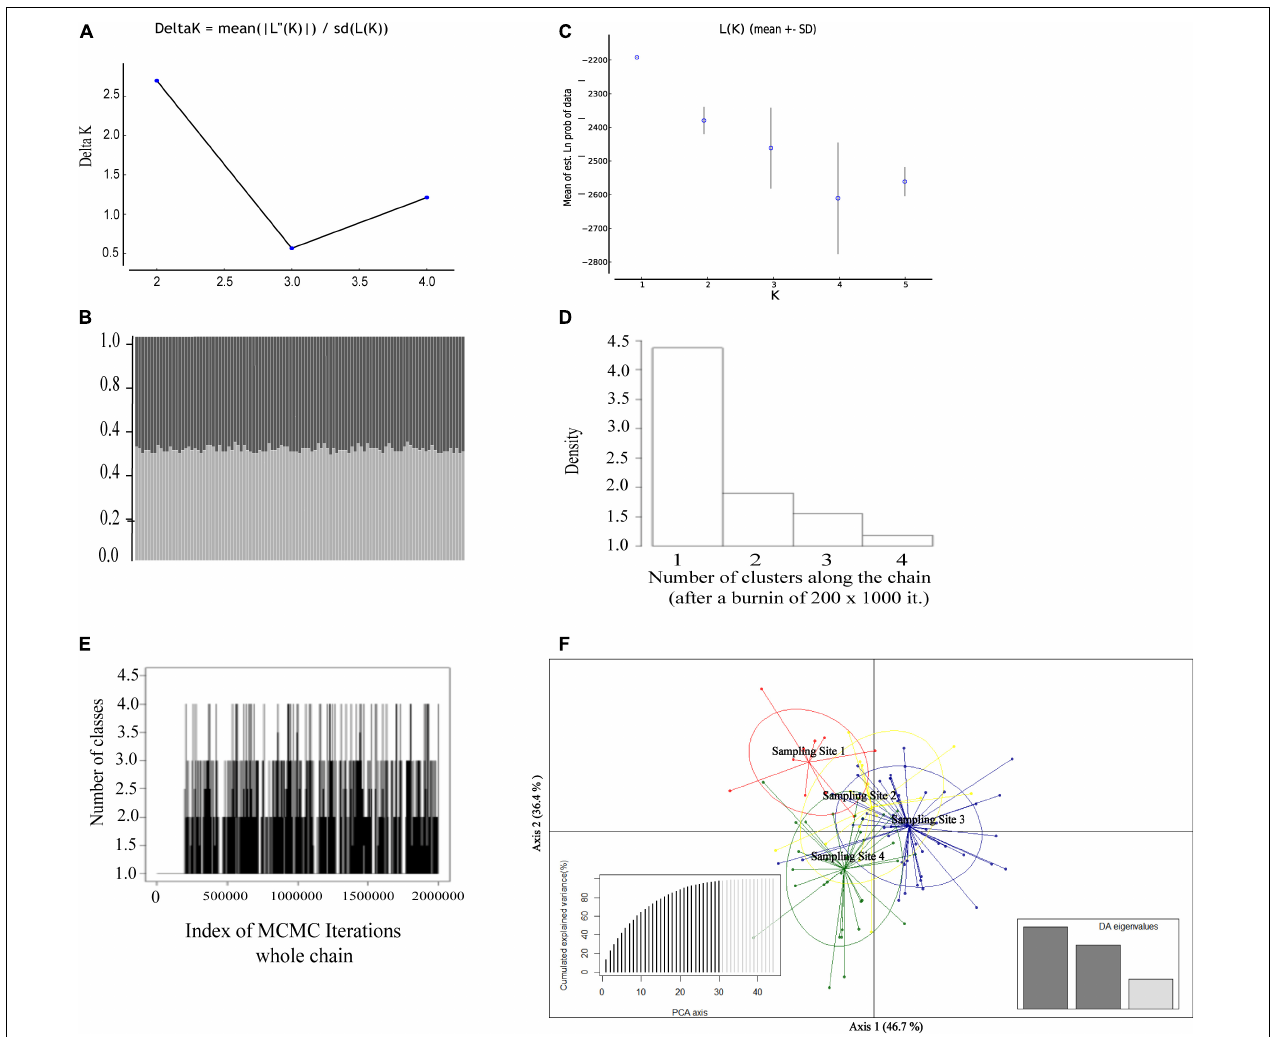
FIGURE 2 | Genetic structure of 107 Myrmecophaga tridactyla specimens assessed by different approaches based on 10 microsatellite loci. (A) Population structure results ( K = 2) based on the (cid:49) K statistic (Evanno et al., 2005). (B) Graphical representation of K = 2 from structure results based on (cid:49) K statistic (Evanno et al., 2005). Each vertical bar represents an individual and each color (light gray and dark gray) represents the posterior probability of the individuals belonging to that cluster. (C) Graphical representation of K = 1 from structure result based on the Ln value (Pritchard et al., 2000). (D) The number of clustering among the chain from GENELAND. (E) Plot of the number of populations simulated from the posterior distribution with GENELAND, indicating K = 1 as the most frequent result. (F) Results of the discriminant analysis of principal components (DAPC) showing the scatterplot of the first two principal components and DA% for each